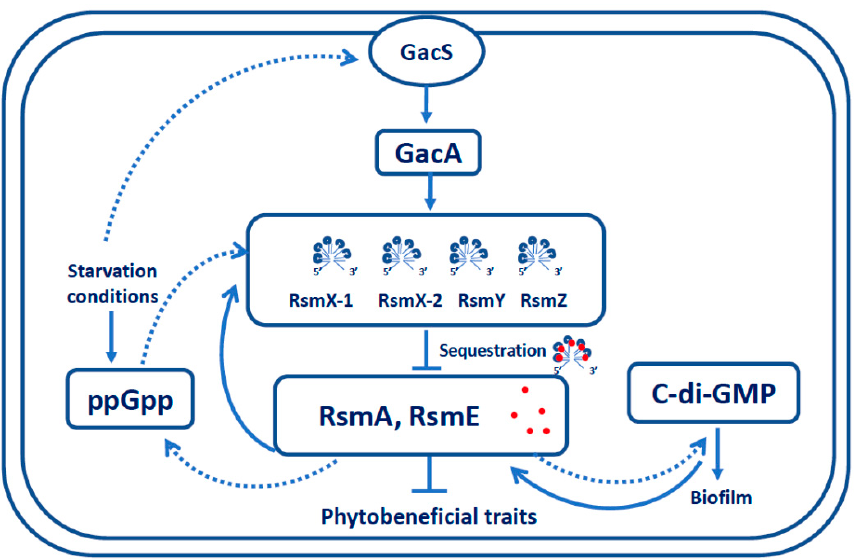
Figure 7. Model for gene regulation by ppGpp and c-di-GMP in the Gac-Rsm system of P. brassicacearum NFM421. This pathway is supported by evidence from this work and previous studies (Lalaouna et al., 2012, Takeuchi et al., 2012, Liang et al., 2020). ↓ , positive effect; ⊥ , negative effect, dotted lines, indirect effects. The new conclusion of this study is that starvation conditions seem to activate the Gac-Rsm system concomitantly with the production of ppGpp and